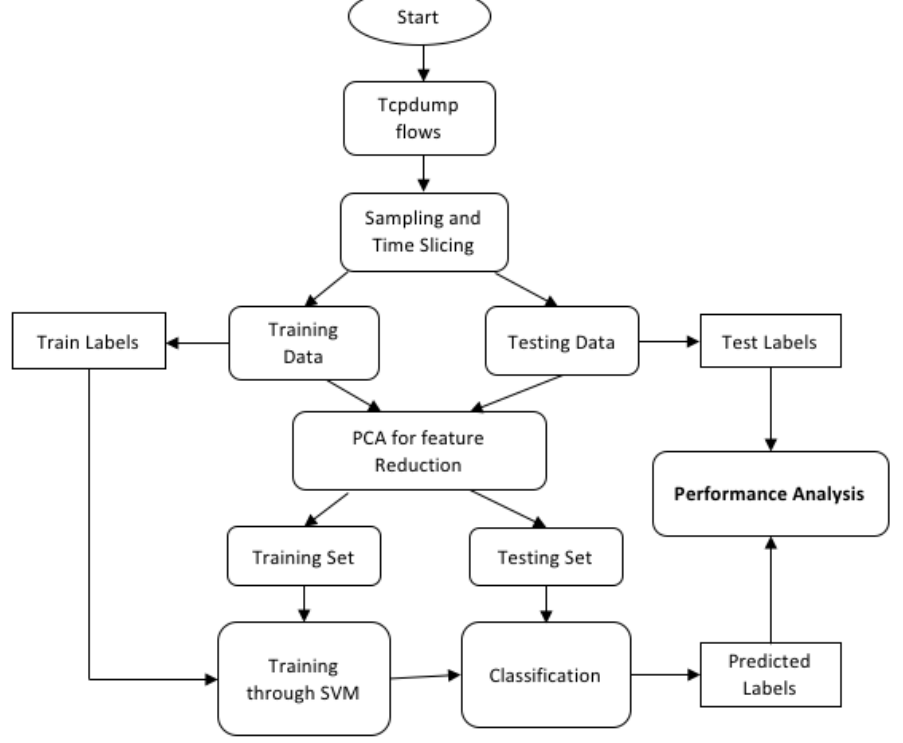
Figure 6. PCA-SVM model [41] adapted for HTTP